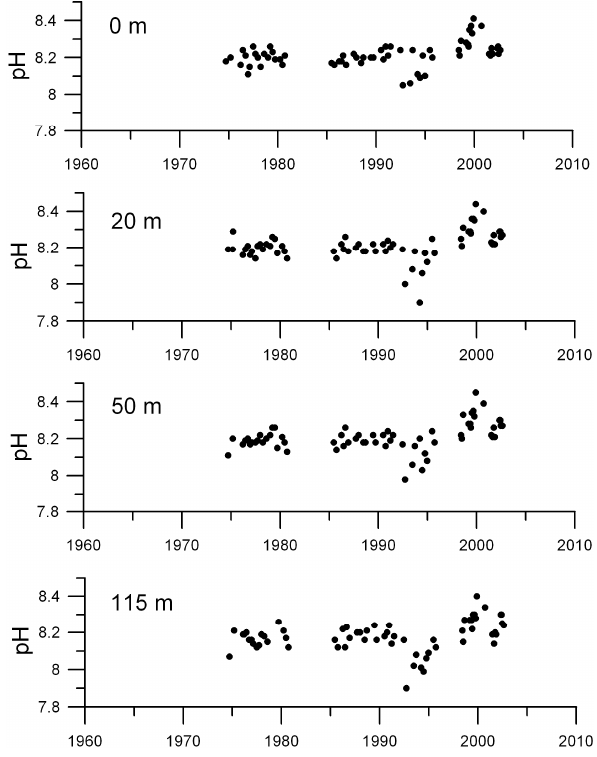
Fig. 5. As in Fig. 3, but for station P5 (115m). Figure 5. As in Fig. 3, but for station P5 (115 m).